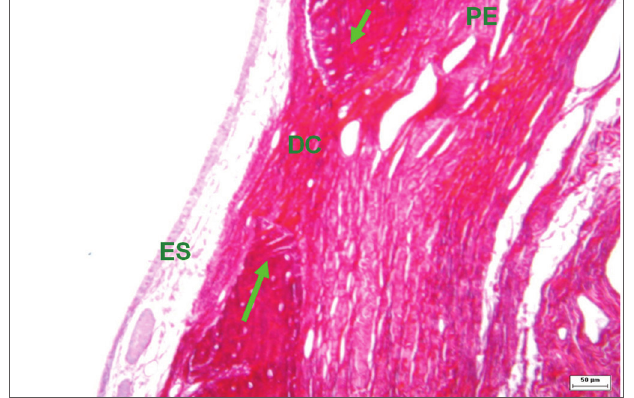
Figure 9. Histological section of an experimental surgical defect not completely filled in by bone (picro sirius red stained), under clear field microscopy - fibrous connective tissue in the surgical defect (DC), where red, orange, and yellow fibers predominate, suggesting type I collagen; sinus epithelium (ES); periosteum (PE); bone ridges (green arrows).